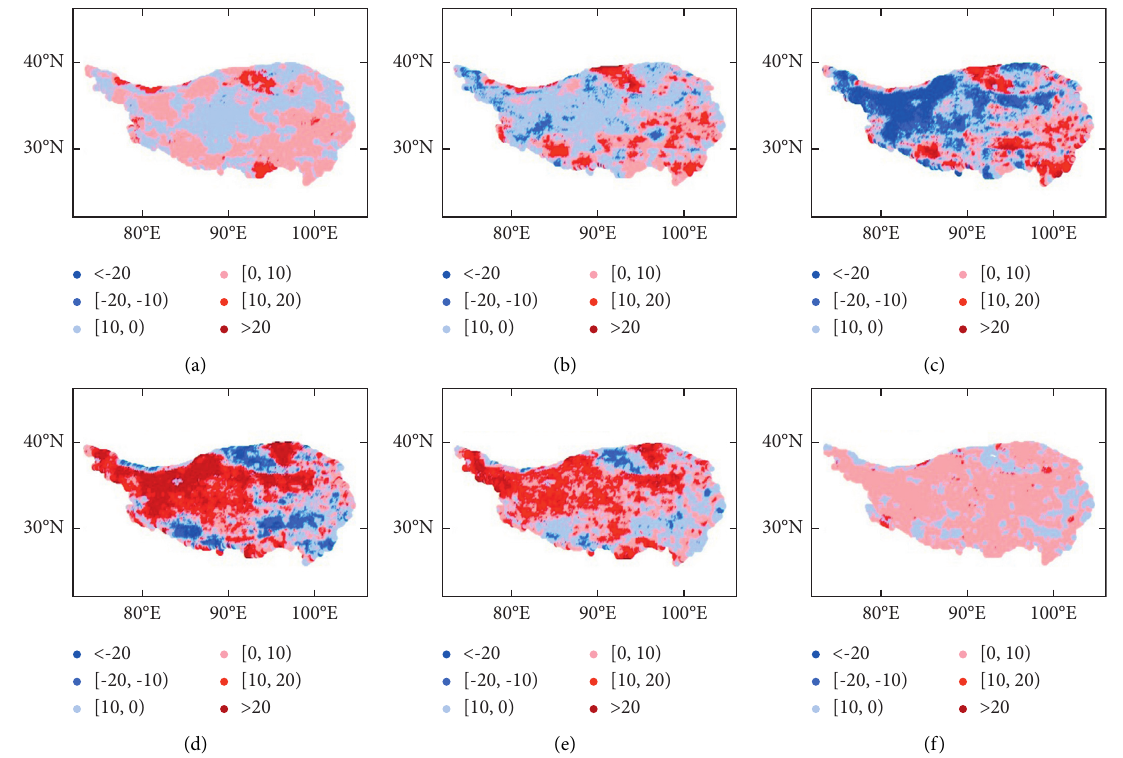
Figure 5: Drought and wetness probability variation before and after 2001 in the QTP (after 2001 values minus before 2001). The red area represents that the probability in 2001–2015 has increased compared with that in 1979–2000, while the blue area represents that the probability has decreased. (a) Extreme drought. (b) Moderate drought. (c) Mild drought. (d) Slightly wet. (e) Moderately wet. (f) Extremely